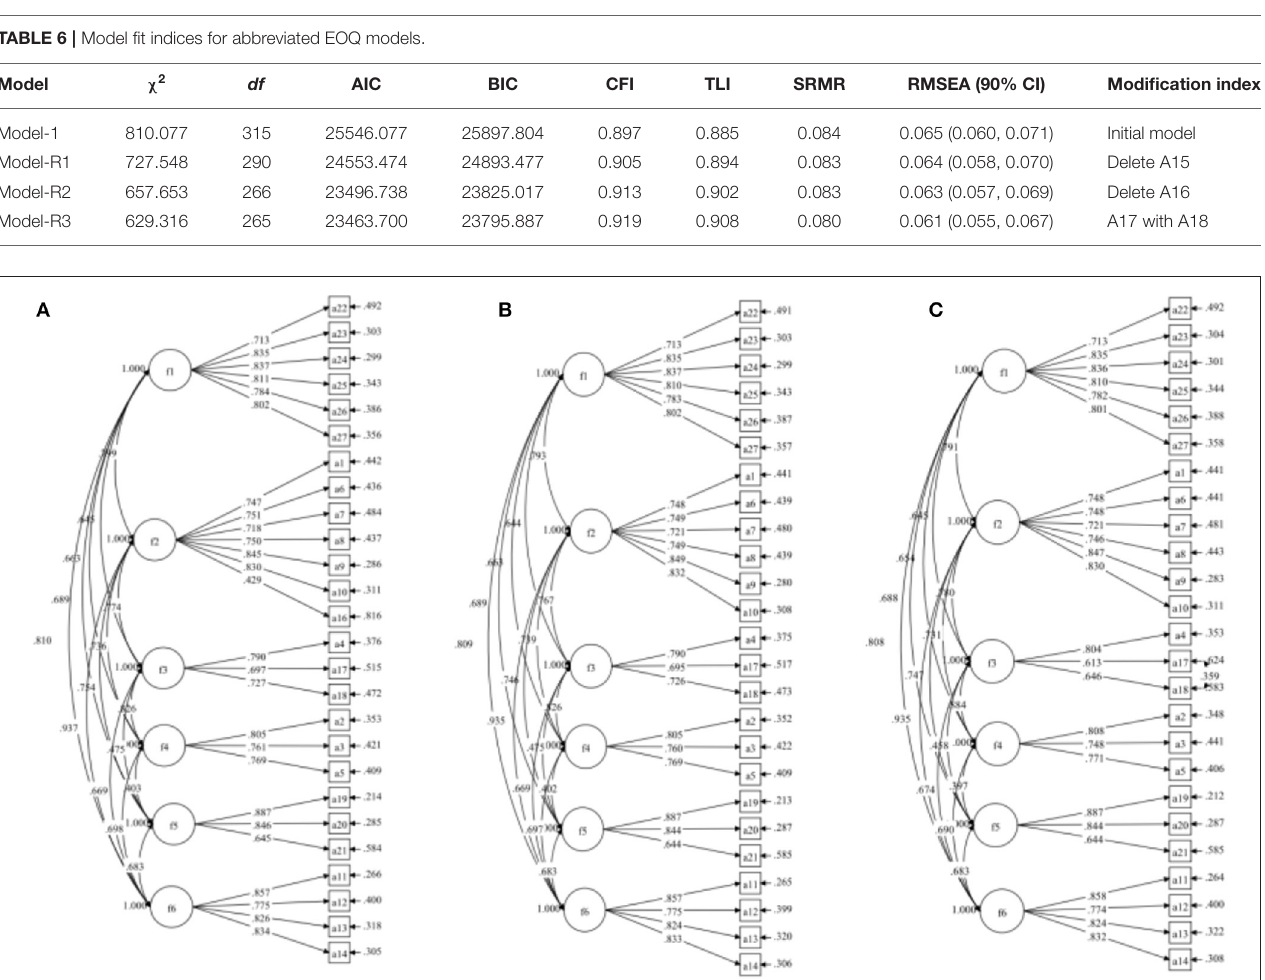
FIGURE 3 | Standardized factor loading for (A) Model-R1, (B) Model-R2, and (C) Model-R3.